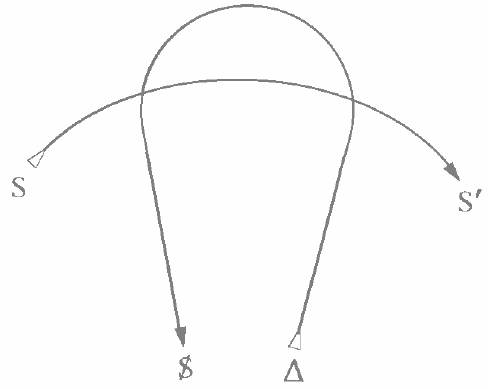
Figure 1. Graph of desire. Source: J. Lacan (1966, p. 805) Subversion du sujet et dialectique du desir , in: Ecrits , Paris, Edition du Seuil.